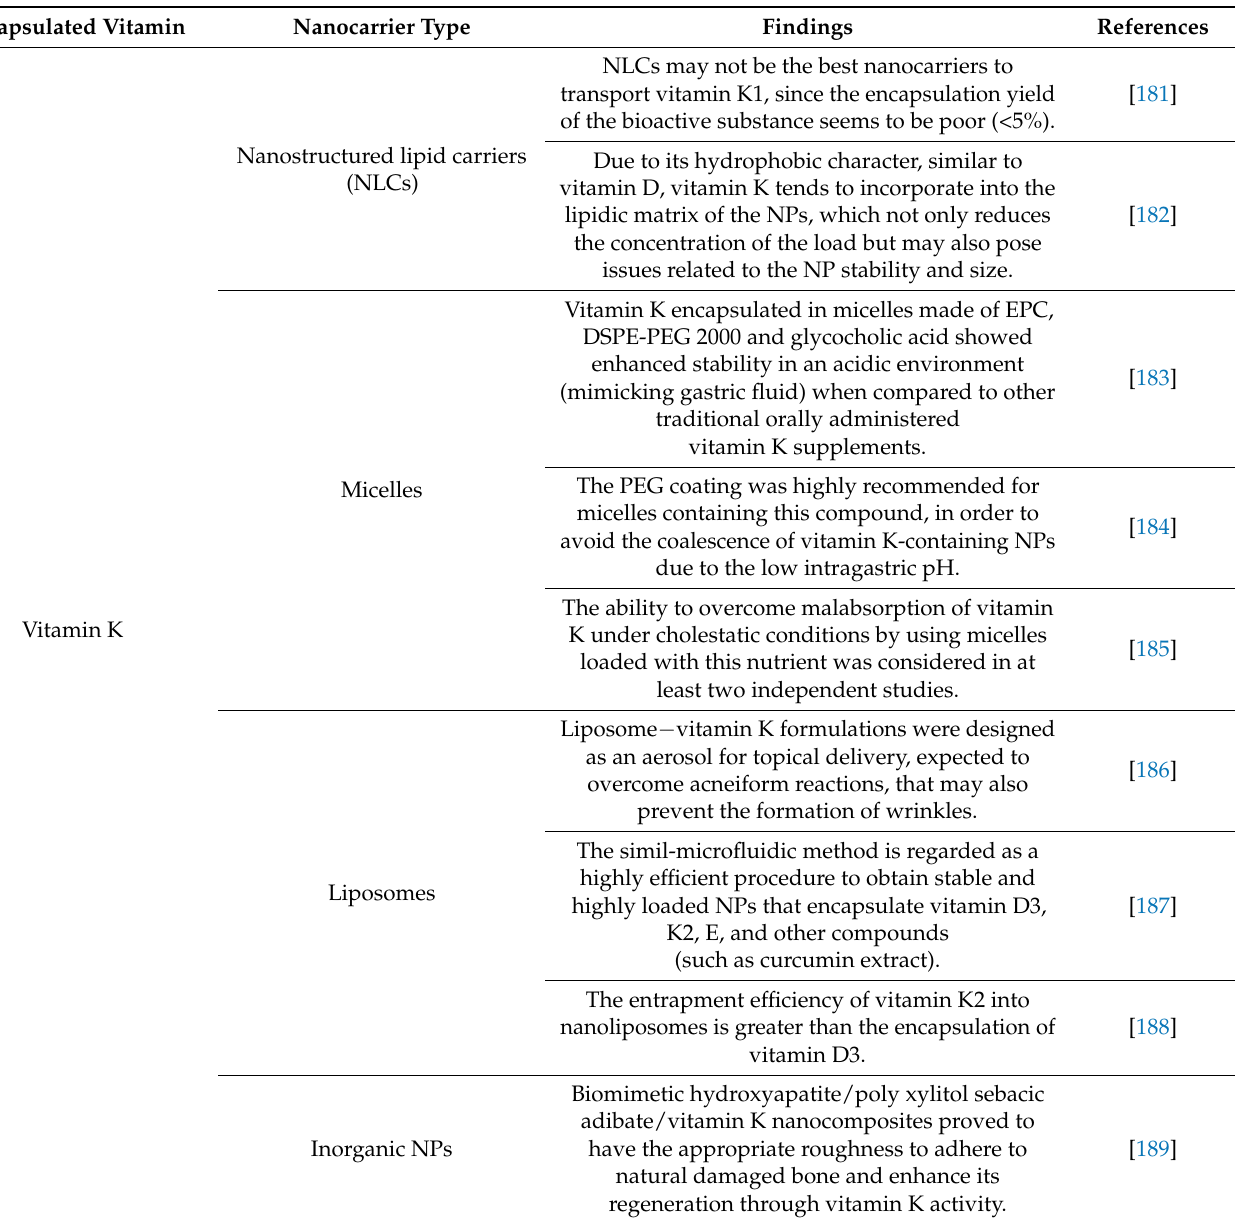
Table 3. Nanoparticle-based formulations for the encapsulation of vitamin K. Encapsulated